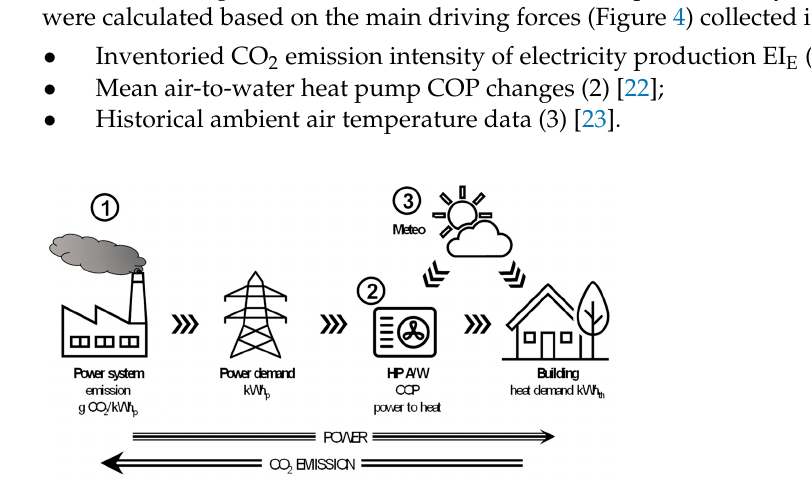
Figure 4. Diagram of power flows and CO 2 emissions of an air source heat pump in power to heat mode.